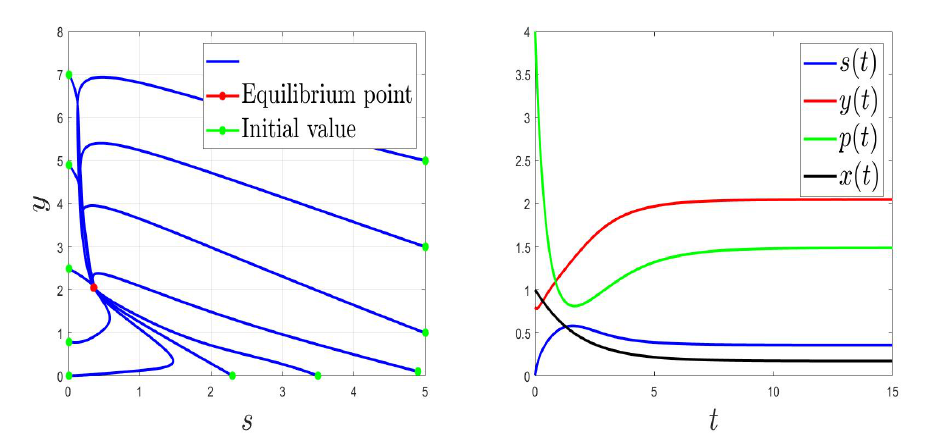
Figure 1. Behaviours for (cid:101) = 0.8, η 1 = 1.4 and η 2 = 2, then R 0 = 4.35 > 1.